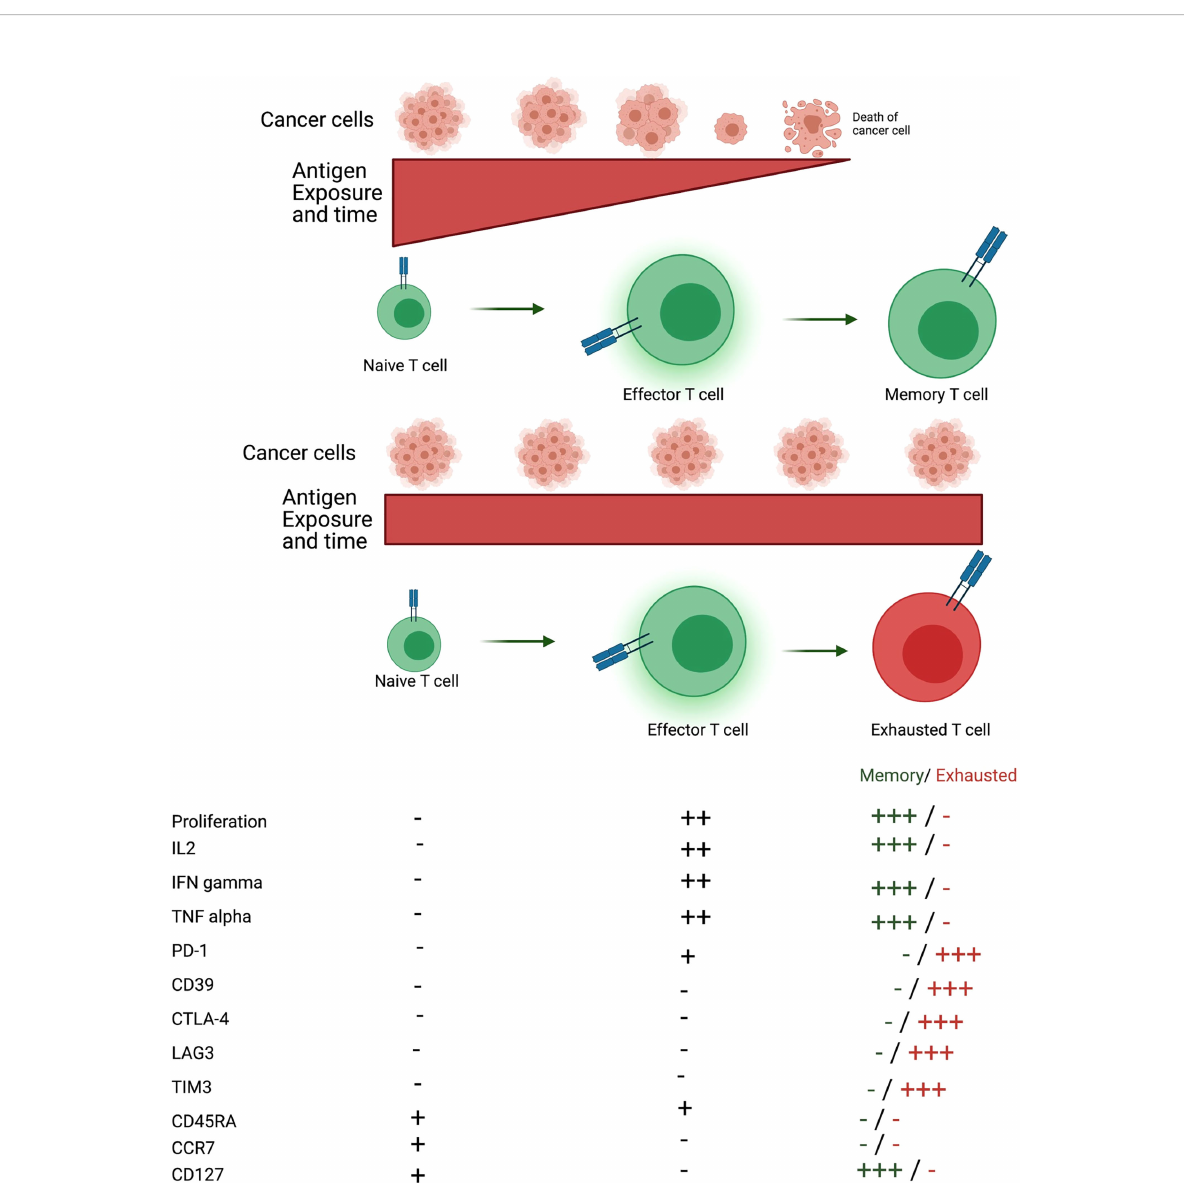
compared to healthy individuals (57).The evaluation of memory T cell populations in blood samples with HPV infection shows higher frequency of effector memory T cells and lower frequency of naïve T cells in HPV+ HNSCC patients compared to HPV- HNSCC patients. There is no difference in the frequency of central memory T cells considering HPV status in HNSCC (57).